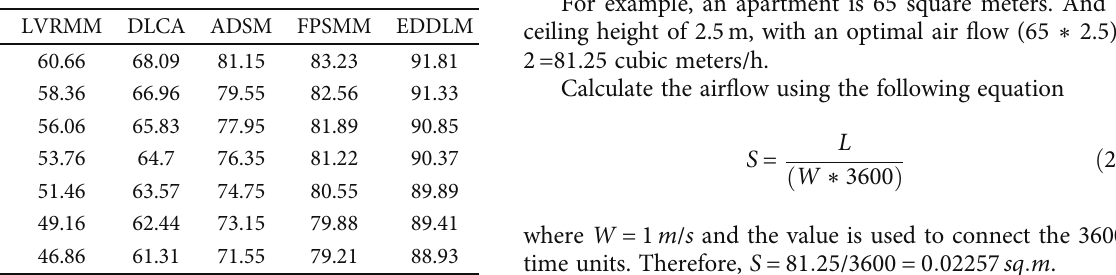
Table 2: Noise protection management.